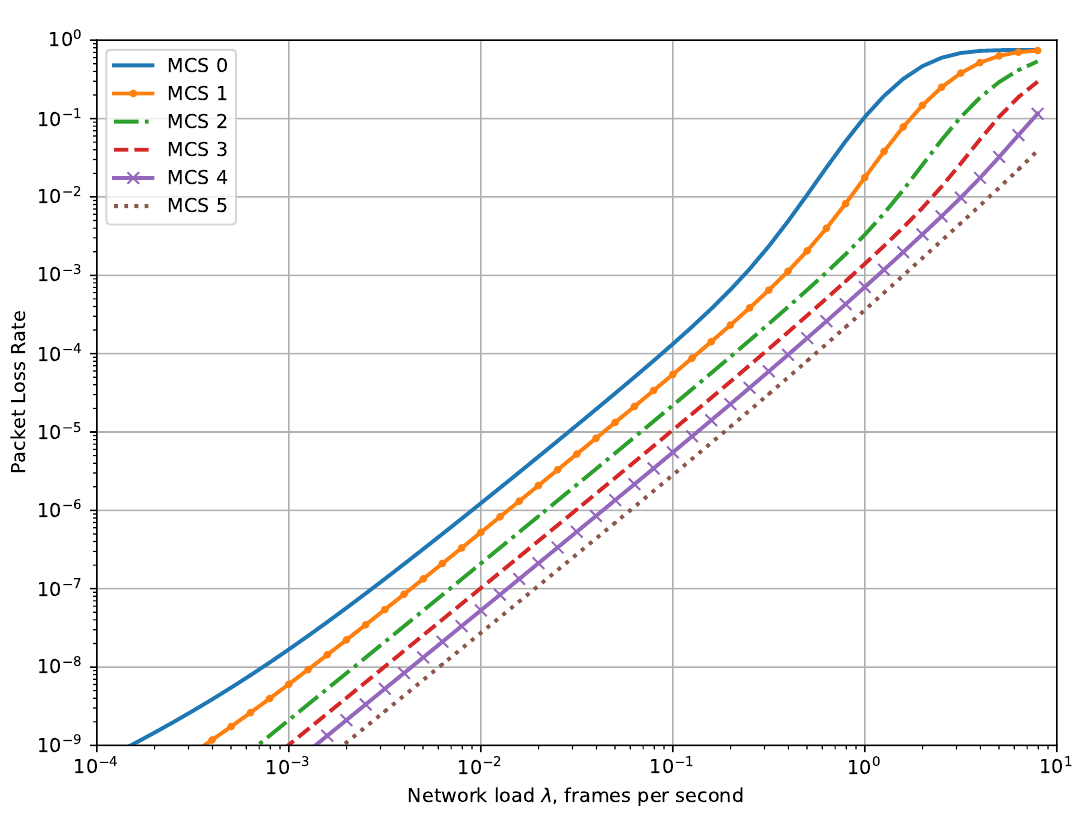
Figure 9. Dependency of PLR on the network load for various MCSs, CR =